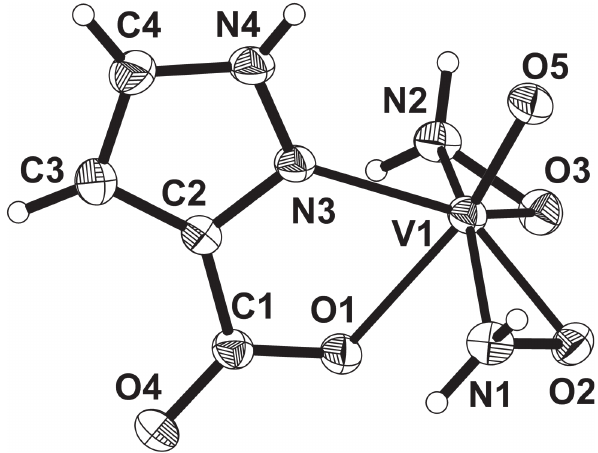
Table 1: Data collection and handling.